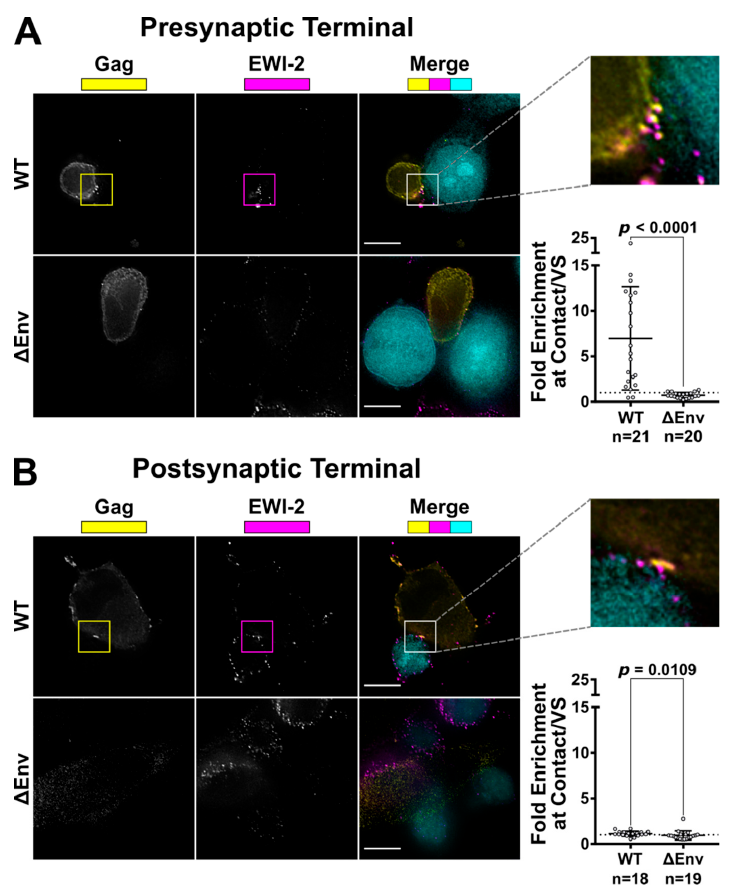
Figure 2. EWI-2 accumulation takes place on the producer cell side of the VS. ( A ) To evaluate presynaptic accumulation of EWI-2, CEM-SS cells infected with HIV-1 NL-CI WT or ∆ Env were co cultured with CMAC (cyan) labeled TZM-bl target cells (which have nearly-undetectable EWI-2 surface levels compared to CEM-SS cells) for 2.5 h, and subsequently stained for surface EWI-2 (magenta) and Gag (yellow). EWI-2 enrichment was quantified as described in Figure 1. Quantification is the result of pooled VS/contacts from two independent biological replicates. ( B ) To evaluate postsynaptic accumulation of EWI-2, HeLa cells (which, like TZM-bl cells, also have nearly-undetectable EWI-2 surface levels) were transfected with HIV-1 NL-sfGI or NL-sfGI Δ Env and cocultured with uninfected CEM-SS target cells (cyan) for 2–2.5 h. Cells were stained for surface EWI-2 (magenta) and Gag (yellow). Note that Gag expression in the ∆ Env condition was quite low, since Gag expression in this virus is already expected to be considerably reduced [55]. EWI-2 enrichment was calculated as described in Figure 1. Quantification is the result of pooled VSs / contacts from two independent biological replicates. Scale bars = 10 µ m. In both data plots, each dot represents the EWI-2 enrichment value of one VS / contact. The dotted horizontal line indicates a theoretical fold enrichment of 1, which indicates no enrichment. Error bars = standard deviation of the mean (SD). p -values are the result of two-tailed non-parametric Mann-Whitney U